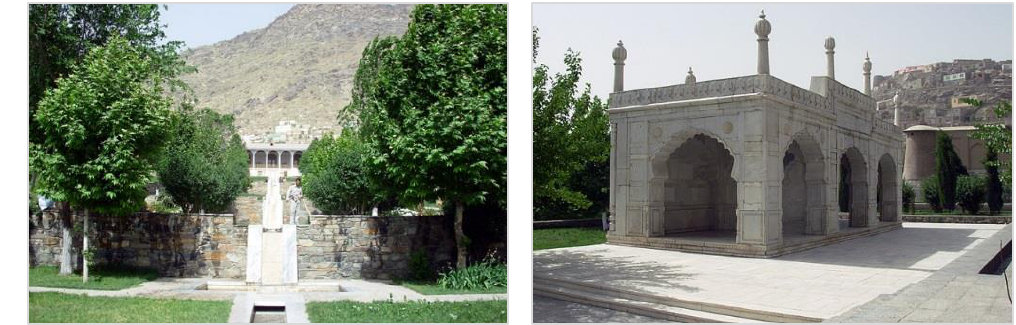
Figure 6 Baghe Babur garden and Babur tomb views (Jodidio, 2017).